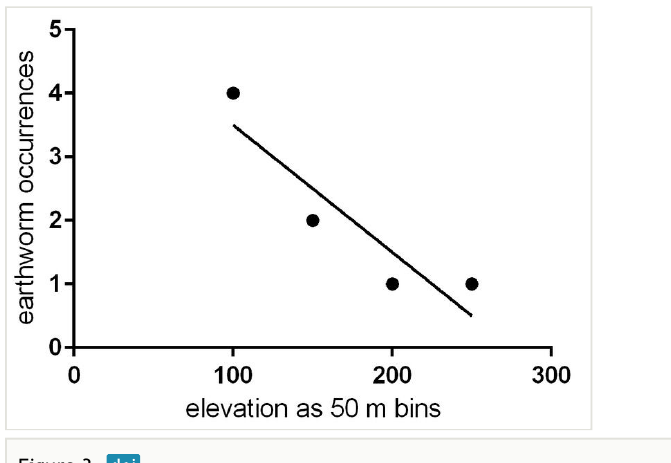
Figure 3. Elevation versus earthworm presence, grouped into bins spanning 50 m elevation. R = 0.8333, slope is not signi fi cantly di ff erent from zero ( p = 0.087). Data are a combination of UAM records contributed by citizens and our standardised sampling data.